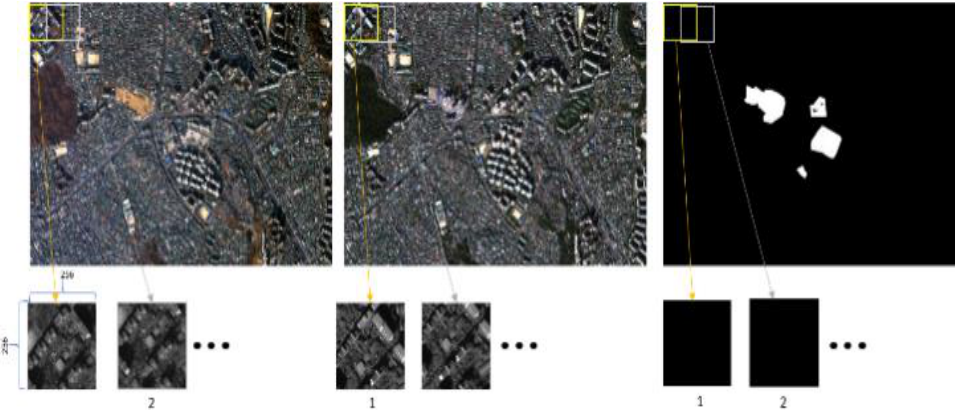
Figure 6. Dataset generation: ( Left ) Image P, acquired in March 2014; ( middle ) Image C, acquired December 2015; ( right ) Ground truth.